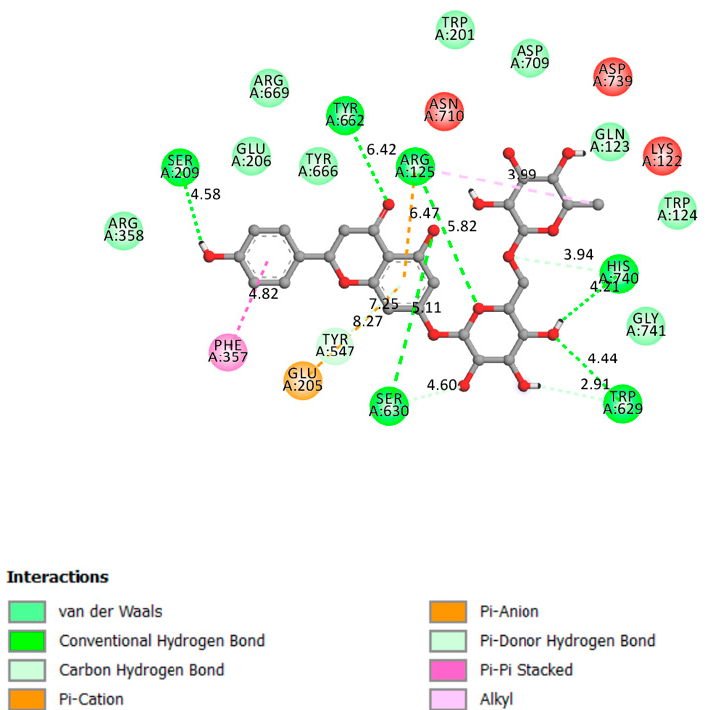
Figure 3. Two-dimensional scheme of the narirutin interactions with DPP4.